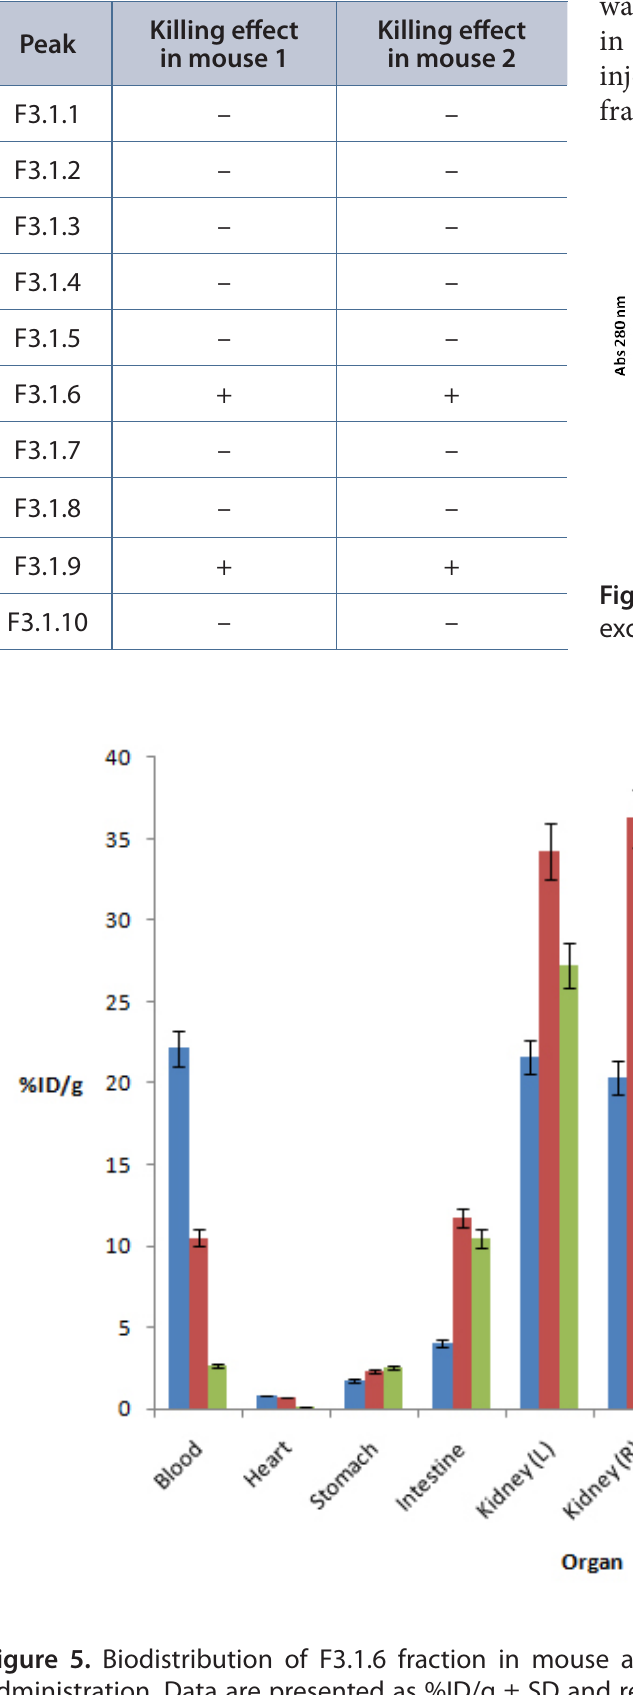
Figure 5. Biodistribution of F3.1.6 fraction in mouse assay at ten minutes, one and four hours after administration. Data are presented as %ID/g ± SD and results are the means of groups of three animals. Values of p < 0.05 are considered statistically